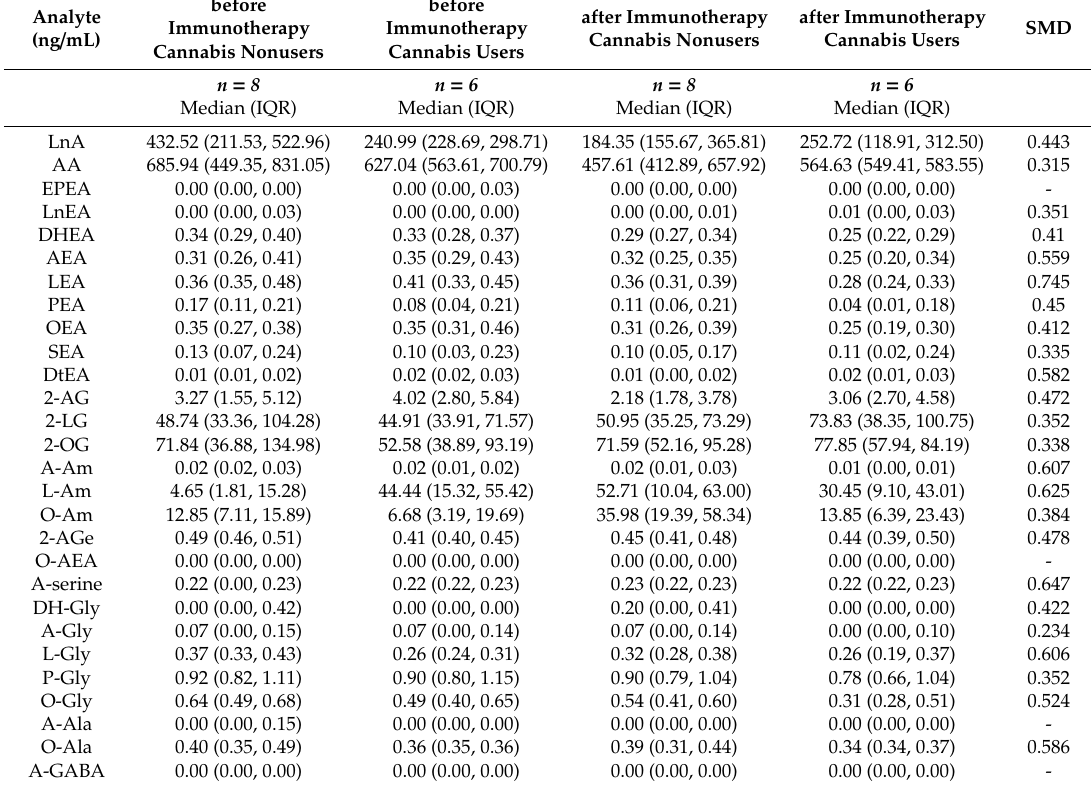
Table 4. Endocannabinoids serum